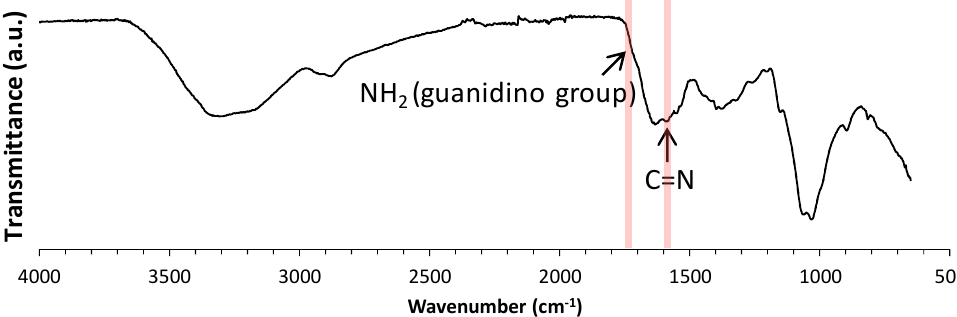
Figure 1. Infrared (IR) spectrum of guanidinylated chitooligosaccharide (GCOS).